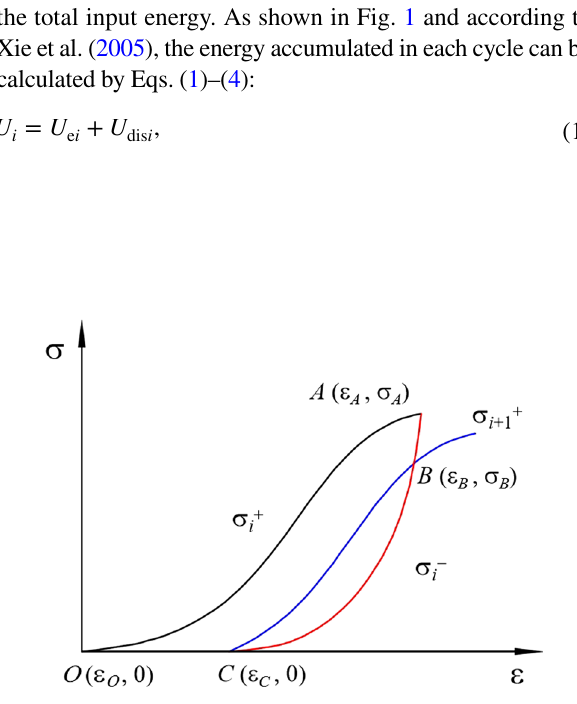
Fig. 1 Stress path of cyclic